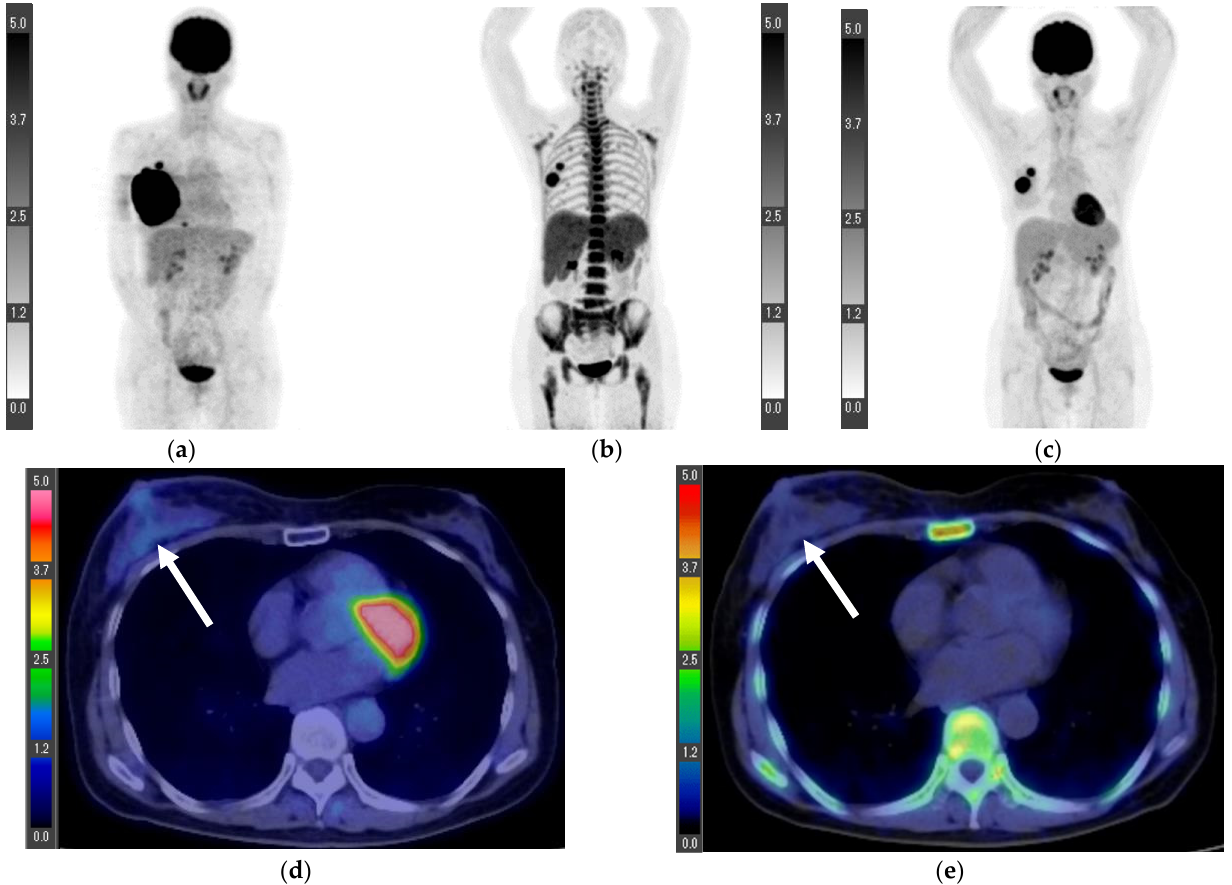
Figure 5. Maximum intensity projection (MIP) of 18 F-FDG PET ( a ), MIP of 18 F-FLT PET 7 months after chemotherapy ( b ), and MIP of 18 F-FDG PET 4 days after the 18 F-FLT PET ( c ). 18 F-FDG accumulation increased in the right breast following chemotherapy (( e ), arrow), whereas 18 F-FLT accumulation was not evident (( d ), arrow). Patient 7 (Figure 5).